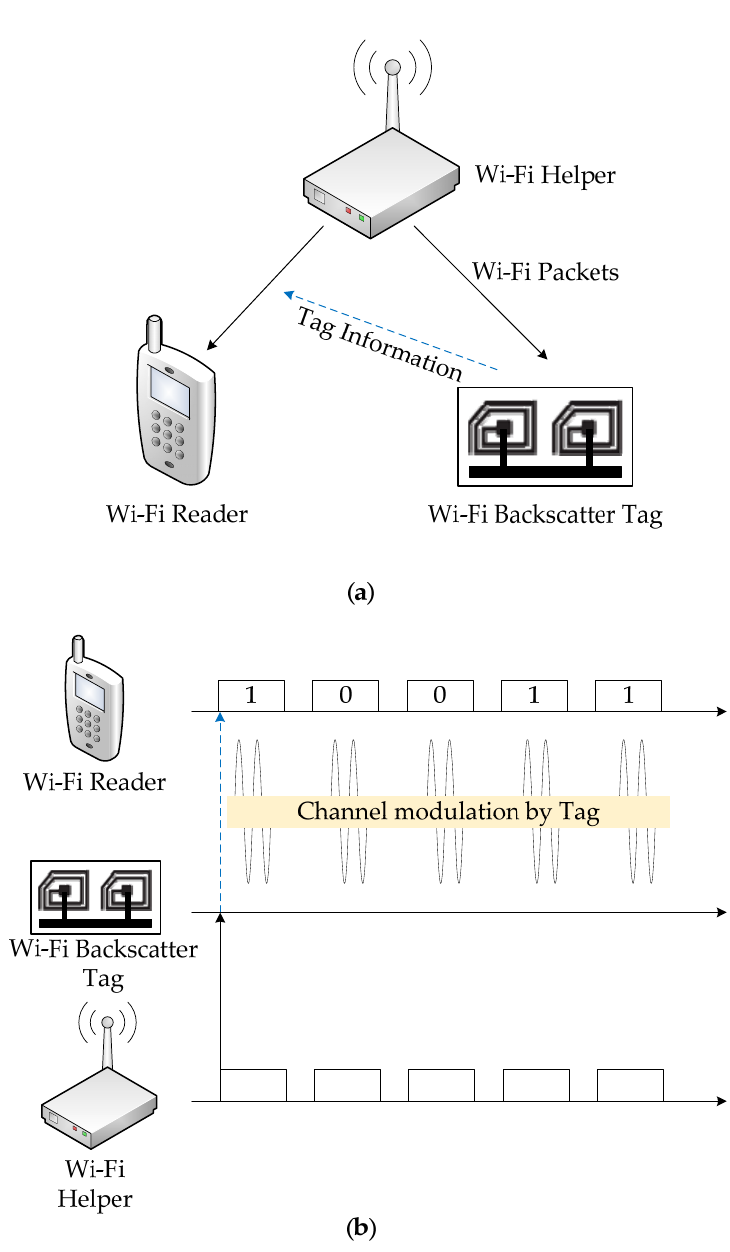
Figure 1. Wi ‐ Fi backscatter uplink communication: ( a ) architecture; and ( b ) operation. Figure 1. Wi-Fi backscatter uplink communication: ( a ) architecture; and ( b )